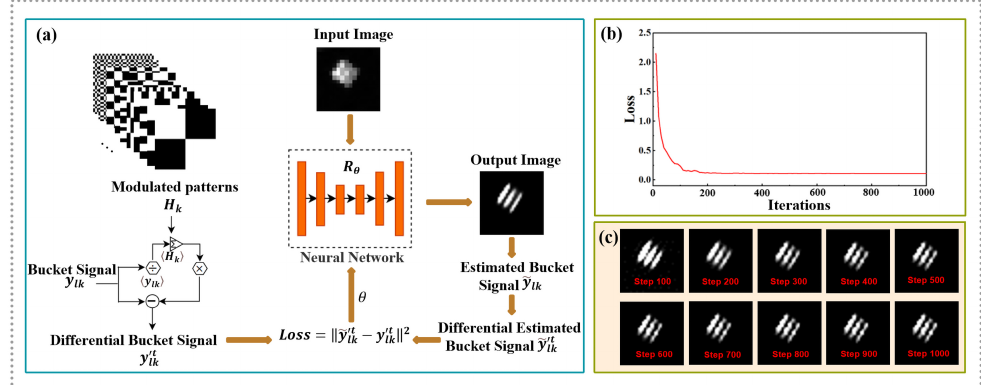
Figure 2. Schematic diagram of network operation. ( a ) The reconstruction image process overview of the proposed method. The measured y lk and H k can be used to obtain low-quality reconstruction results, which are then used as the input of the neural network. At the same time, the differential value y (cid:48) t of the y lk is also input into the neural network. The output of the neural network is multiplied lk with H k to obtain the estimated bucket signals by the network. Then we obtain its differential value ˜ y (cid:48) t and measure the MSE between y (cid:48) t and ˜ y (cid:48) t as the loss function to optimize the weight θ of the lk lk lk neural network. ( b ) Loss value along with the iterative steps from 1 to 1000. ( c ) The corresponding reconstruction images of these steps (display every 100